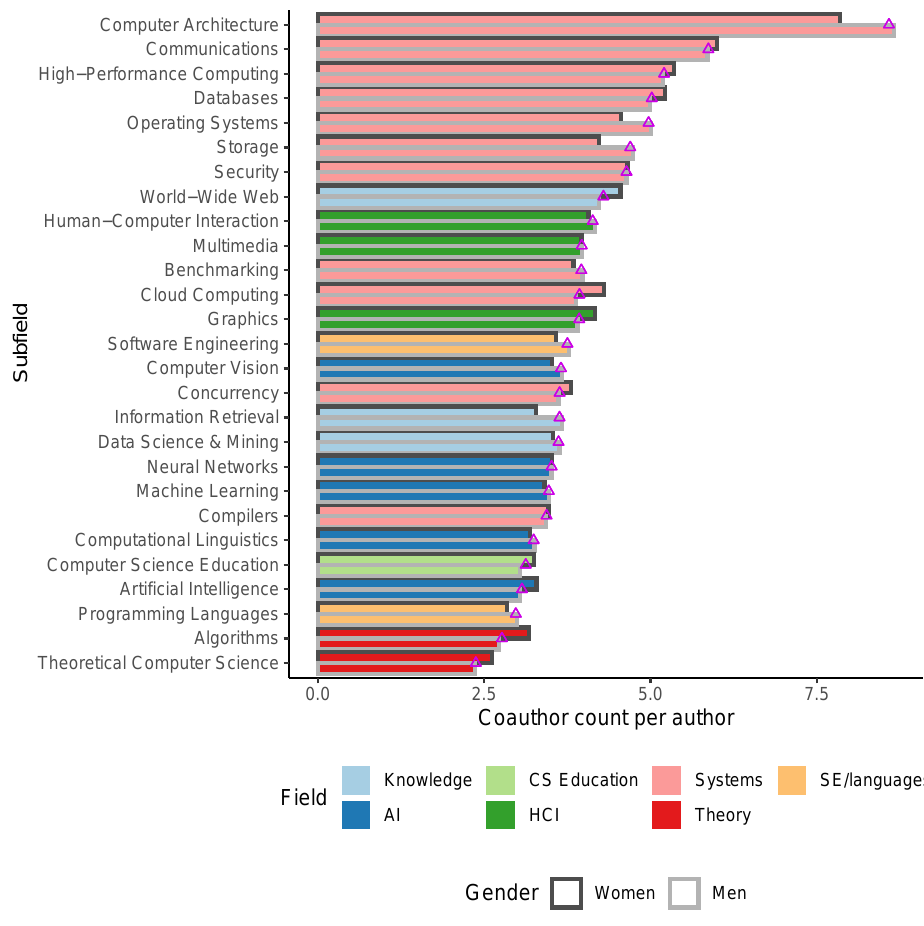
Figure 5. Mean number of coauthors per person by gender and subfield. Triangles denote overall mean for subfield (for both genders), which is used for sorting